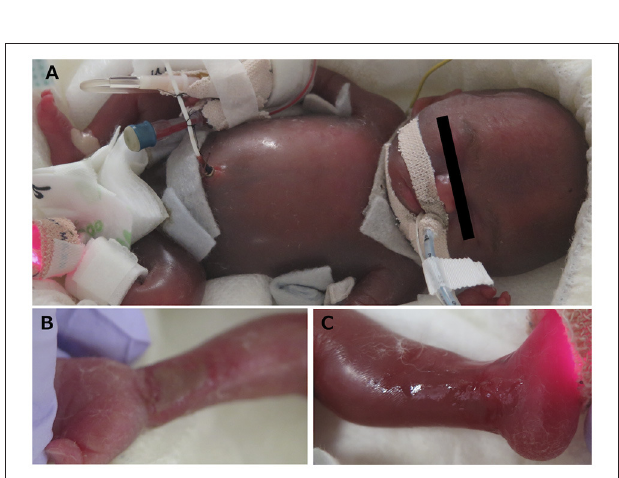
FIGURE 2 | (A) Severe general edema was detected by hydrops fetalis. (B,C) Desquamation and skin erosions were detected by